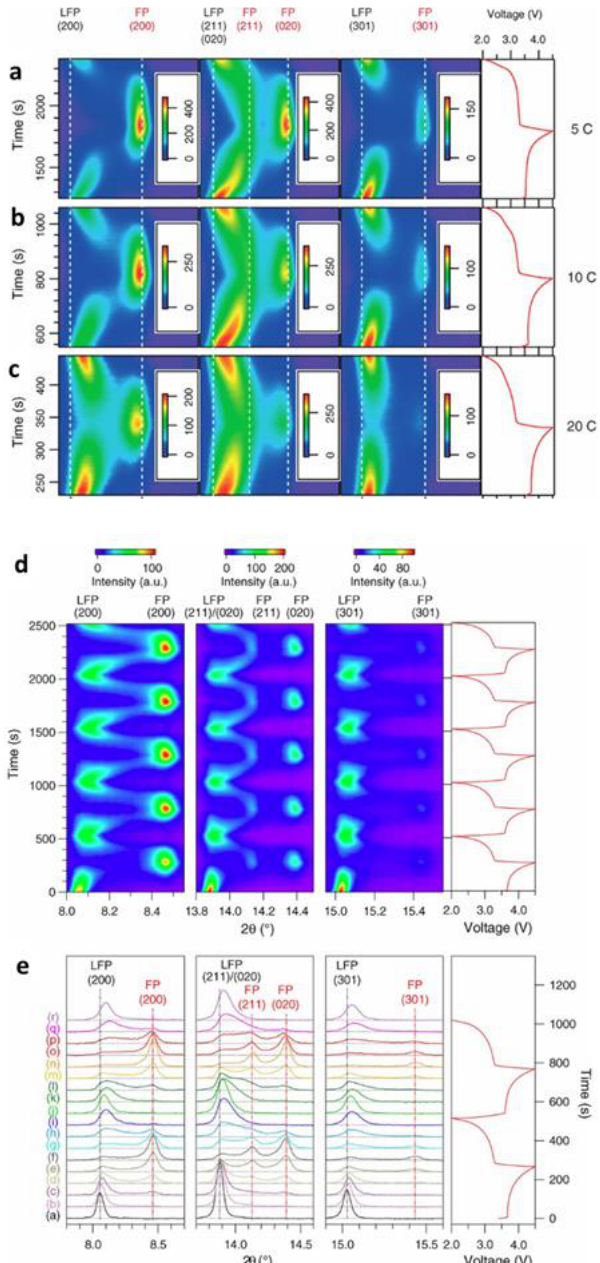
Figure 3. ( a – c ) Image plots of operando XRD patterns of LFP collected at 2nd cycle at rates of 5, 10, and 20C. ( d ) Image plots of XRD spectra collected at 10C rate for 5 cycles; ( e ) Selected diffraction patterns during the first two cycles. The corresponding cycling curves are at right of the spectra [141]; with permission from AAAS.